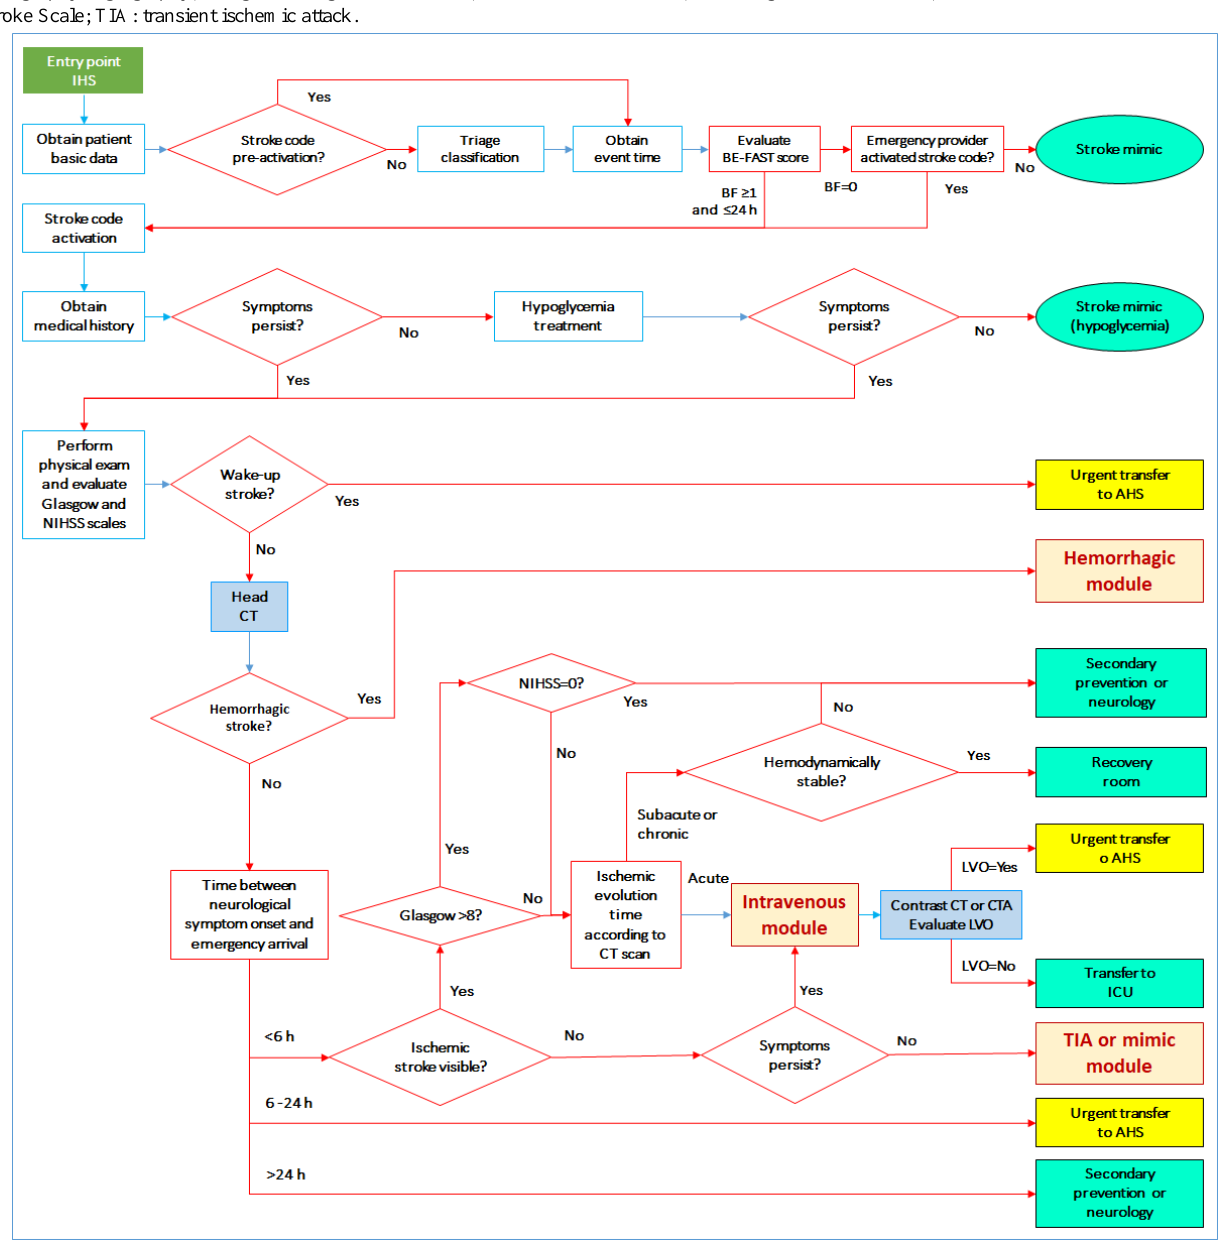
Figure 4. Workflow for the intermediate health care setting (IHS). AHS: advanced health care setting; CT: computed tomography; CTA: computed tomography angiography; Glasgow: Glasgow Coma Scale; ICU: intensive care unit; LVO: large vessel occlusion; NIHSS: National Institutes of Health Stroke Scale; TIA: transient ischemic